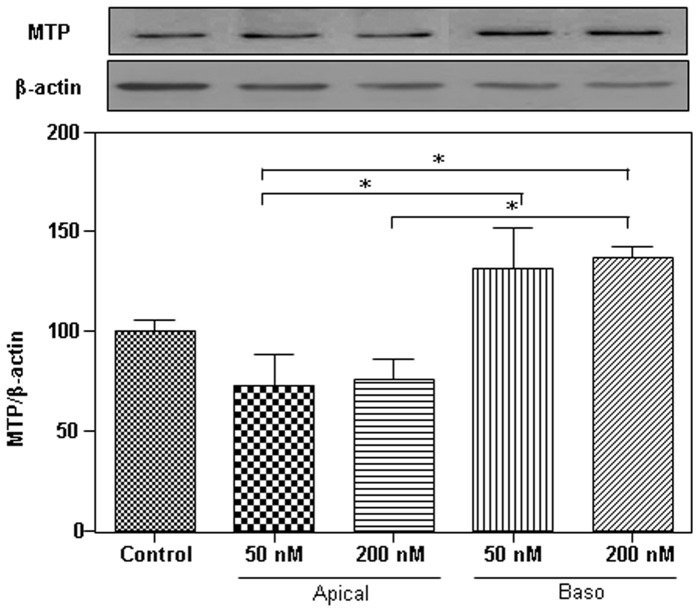
Effects of the administration of PYY (1–36) to the apical or basolateral medium on the protein expression of MTP.Caco-2/15 cells were cultured for 24 h in MEM as described in the legend of Figure 2. Western blot was used to analyse the protein expression of MTP. Data represent means ± SD for n = 3 separate experiments in each group and are reported as % of control values representing 100%. * P<0.05 vs. 50 nM or 200 nM in apical side.